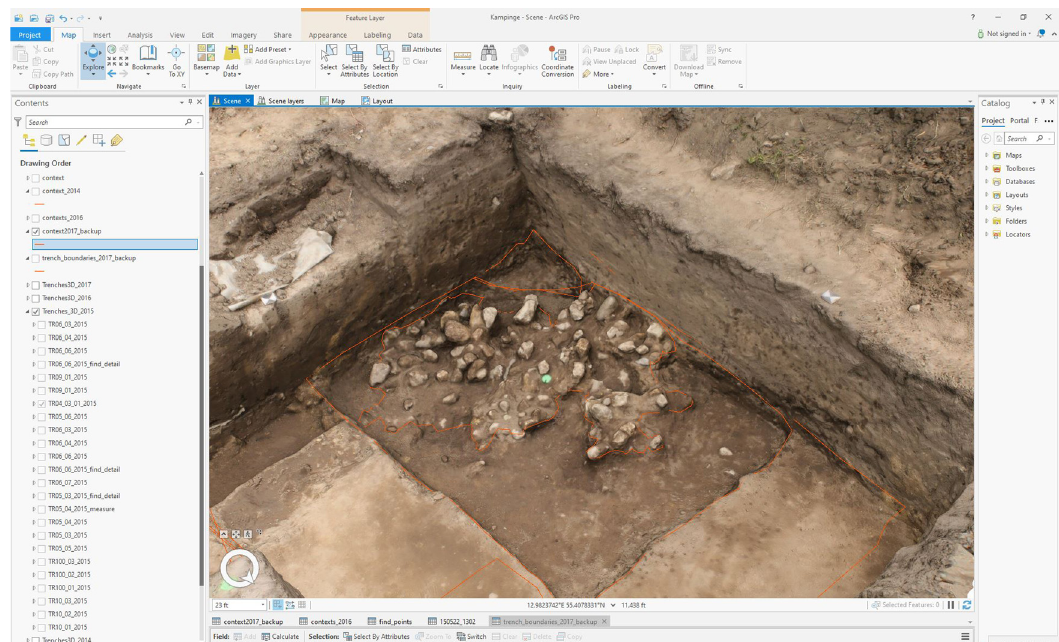
Figure 6: 3D models of trench 9 excavated during the excavation campaign 2016. The model was generated and implemented into the 3D GIS during the excavation. The model was visualized in the fi eld using a Tablet computer and was used as geometrical reference for drawing the contexts. This method allowed verifying the quality of the graphic representation against the real